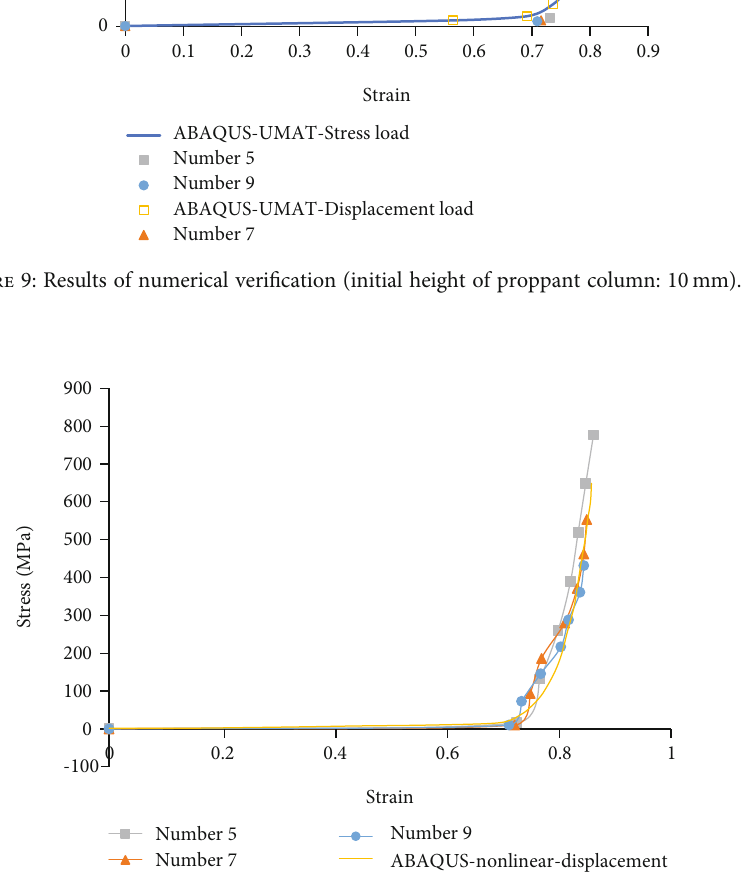
Figure 10: Results of numerical veri fi cation (initial height of proppant column: 8 mm).